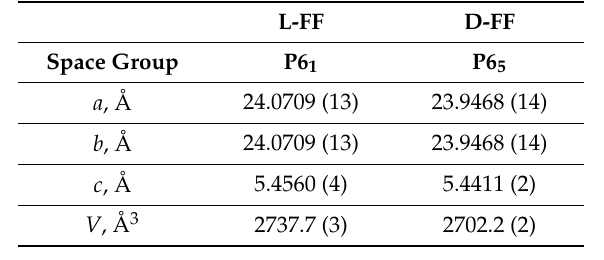
Table 1. Lattice cell parameters for L-FF and D-FF PNT (from references [25,29,33] according to CCDC [39]).